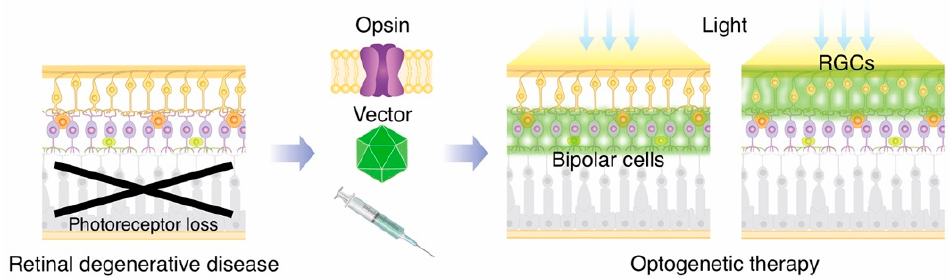
Figure 2. Basic concept of optogenetic therapy for visual restoration. Photoreceptors are lost in eyes with retinal generative diseases. Using gene transfer techniques, remaining retinal cells such as bipolar cells or retinal ganglion cells (RGCs) are converted into artificial photoreceptors.